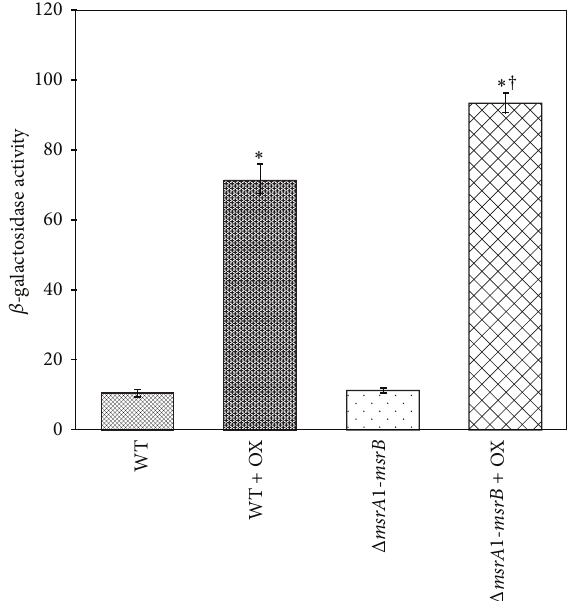
Figure 6: Analysis of msrA1/msrB promoter- lacZ fusion in wild- typeand msrA1 - msrB doublemutantof S. aureus COLinresponseto oxacillin. At OD 600 = 0.5, cells were treated with oxacillin for 2 h and the 𝛽 -galactosidase activity levels were measured. Values indicate averages of data from at least three independent experiments ± standard error ( ∗ significant between samples with and without oxacillin at 𝑝 ≤ 0.05 ; † significant between oxacillin treated wild- type and the oxacillin treated msrA1-msrB double mutant at 𝑝 ≤ 0.05